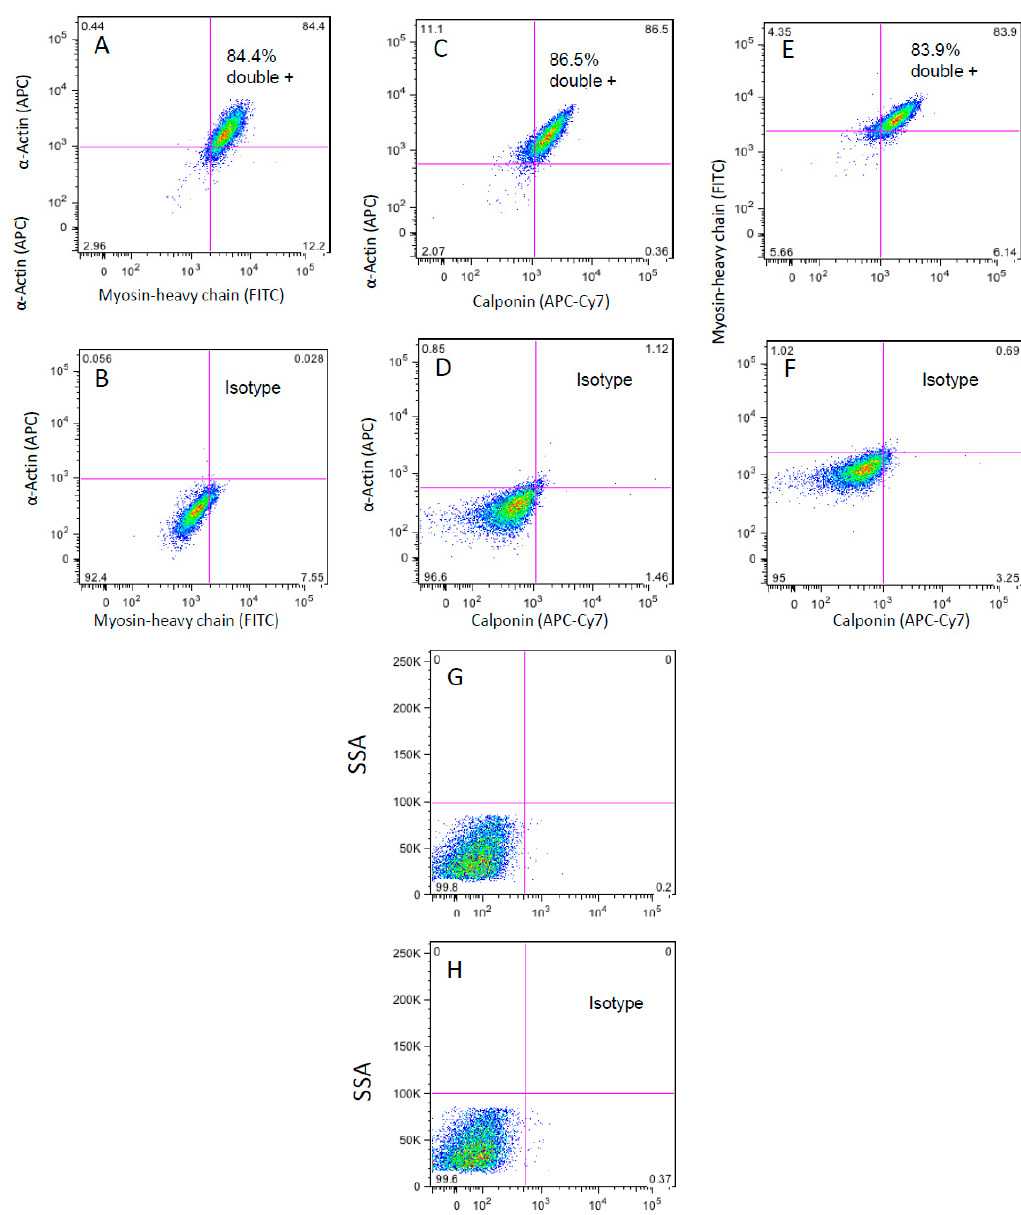
Figure 4. Purity analysis of isolated VSMCs with flow cytometry showing α -actin and myosin heavy chain-positive cells at the 20th passage and 80%–90% confluency. ( A ) Isotype control; ( B ) WG-59 cells; ( C – D ) purity analysis of isolated VSMCs with flow cytometry showing α -actin- and calponin-positive cells at the 20th passage and 80%–90% confluency; ( E – F ) purity analysis of isolated VSMCs with flow cytometry showing myosin heavy chain- and calponin-positive cells at the 20th passage and 80%–90% confluency; ( G – H ) purity analysis of isolated VSMCs with flow cytometry showing smoothelin and the isotype control of WG-59 cells at the 20th passage and 80%–90% confluency. Histogram plot of Smoothelin expression (G). Isotype control in pseudo color plot (H).